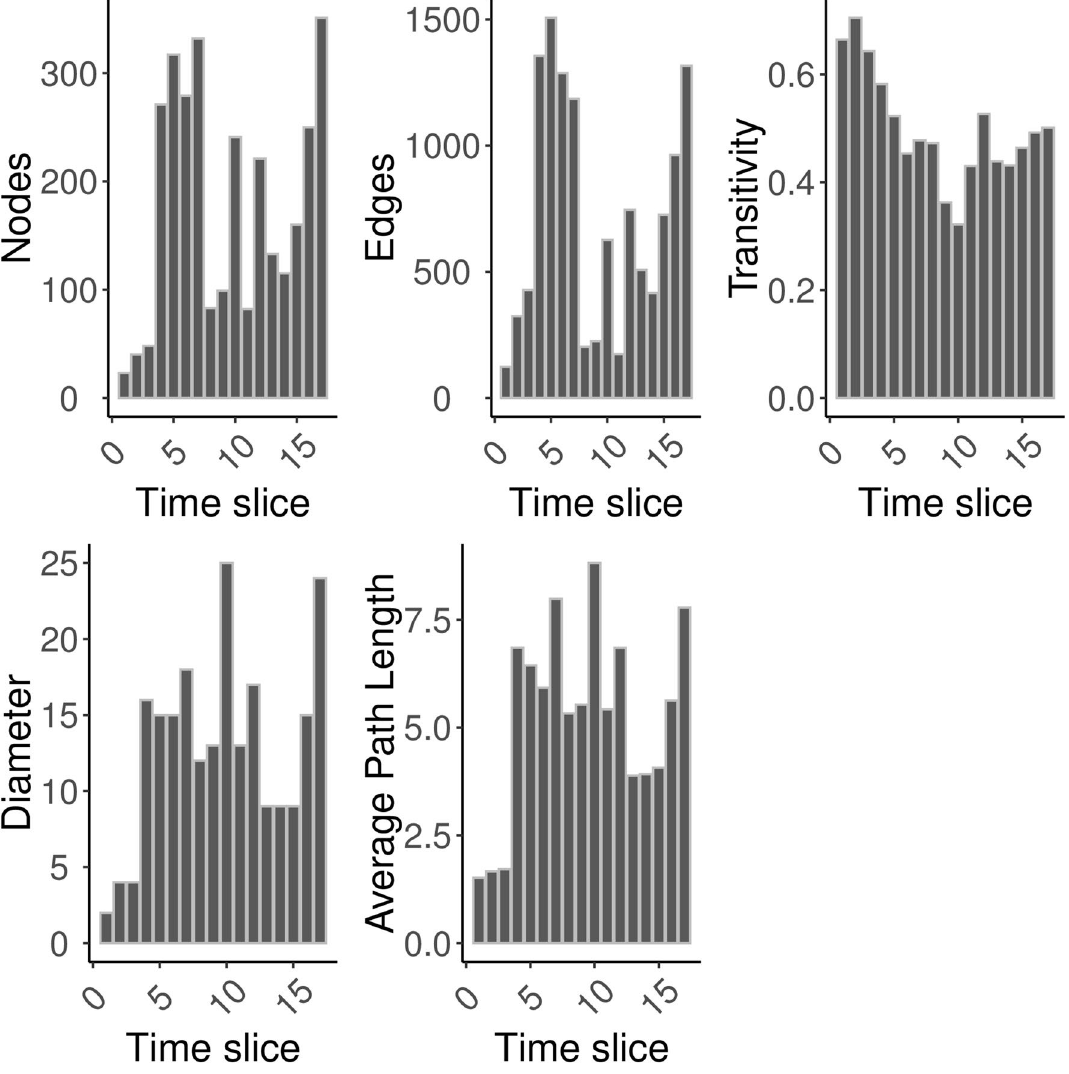
Figure 2. Global metrics for the NECTEC researchers